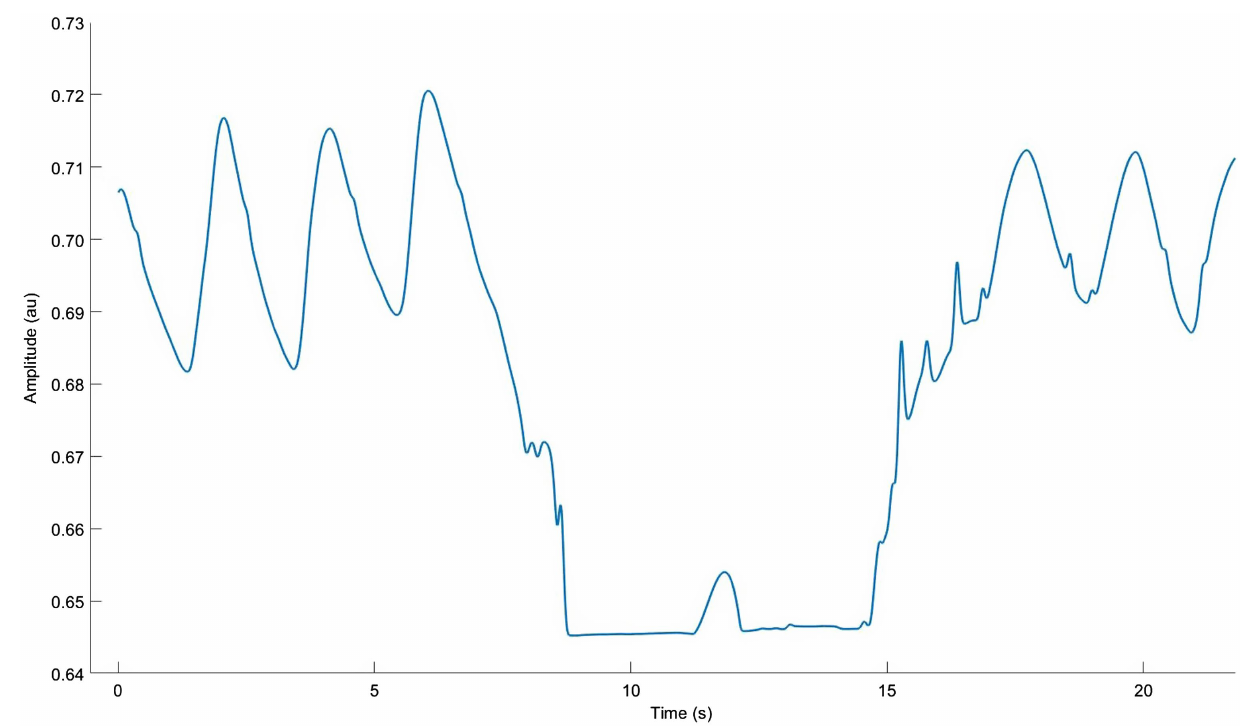
FIGURE 8 | Respiratory inductance plethysmography data from our lab showing normal breathing with one approximate 10 s end-expiratory breath hold. Note the very long double exhale and brief diaphragm